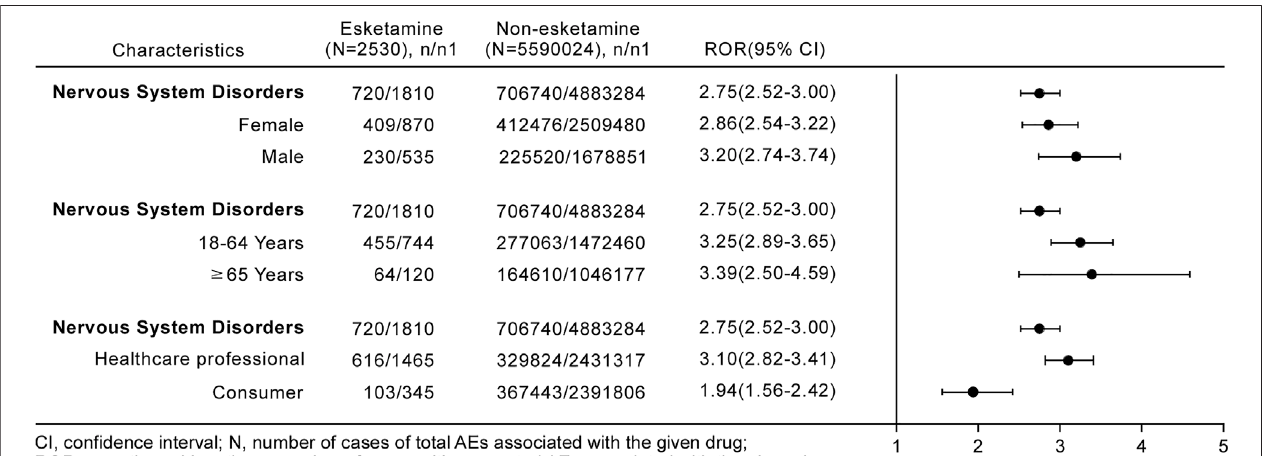
FIGURE 4 | Strati fi cation analysis of esketamine-induced nervous system disorders.